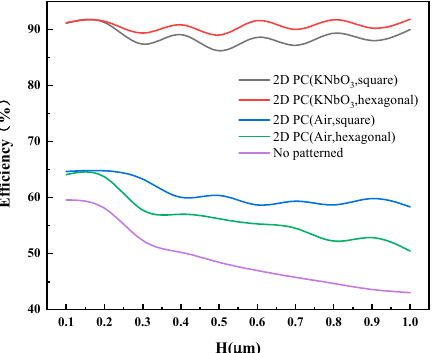
Figure 11. The total efficiency of the absorption layer with different types of scatterers.